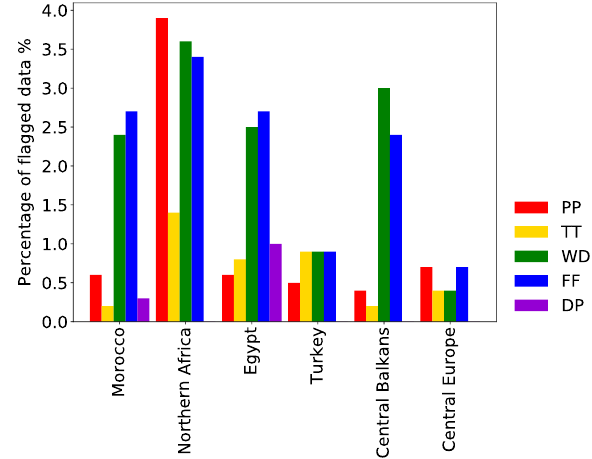
Figure 11. The percentage of values flagged within each network (see Table 5) tested using the HQC automatic procedure. Variable acronyms are as explained in the caption for Table 1, noting that not all variables were included in each